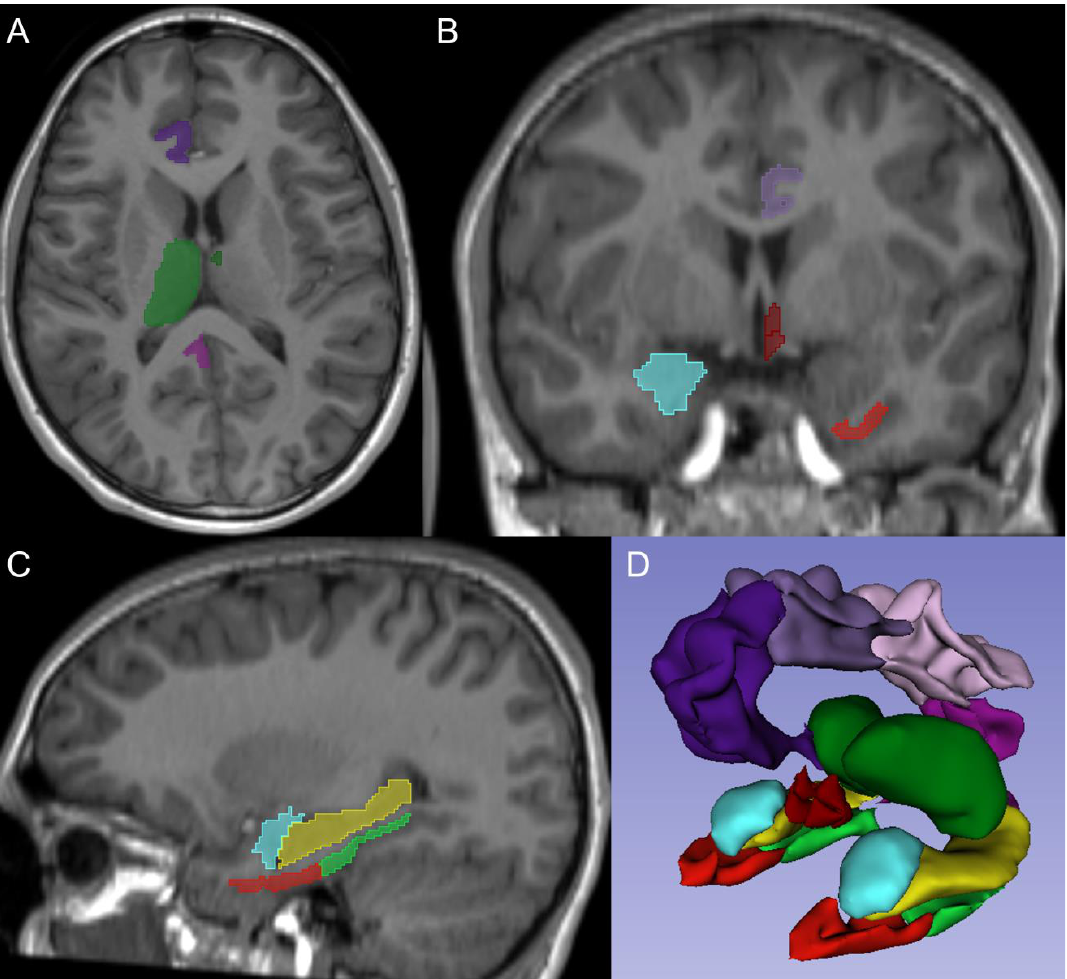
Figure 1. Regions of interest overlay. A – C demonstrate axial, coronal, and sagittal T1-weighted MR images with right cingulate gyrus (pink and purple), whole right thalamus (green), and left antero-ventral nucleus of the thalamus (dark green) in A ; right amygdala (light blue), left hypothalamus (dark red), left cingulate gyrus (purple), and left entorhinal cortex (light red) in B ; and left amygdala (light blue), left entorhinal cortex (dark red), left parahippocampal cortex (green), and left hippocampus (yellow) in C . D shows a 3D reformat of the regions of interest using the same color coding as A – C .